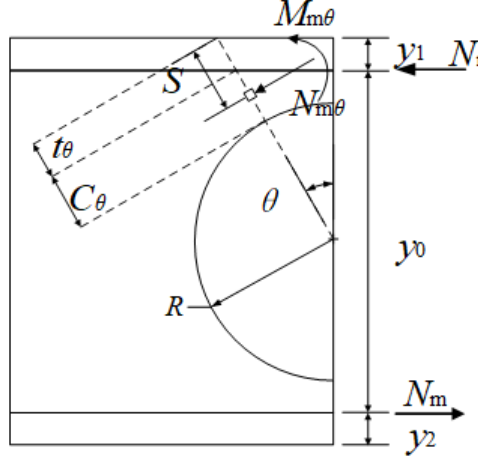
Figure 14. Bend Figure 14. Bend model.